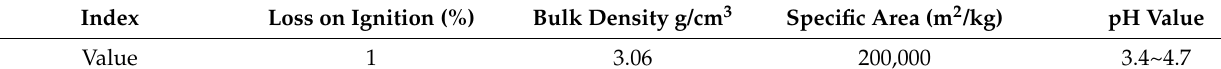
Figure 3. ( a ) SEM, ( b ) EDS. Micro characteristics of Portland cement.